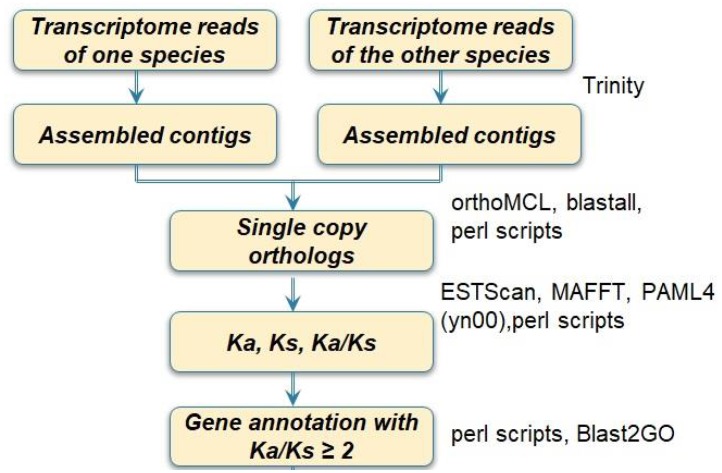
Flowchart of transcriptome sequence analyses for one species pair.The process was repeated for 20 pairs. A customized pipeline of programs was developed for running these steps.